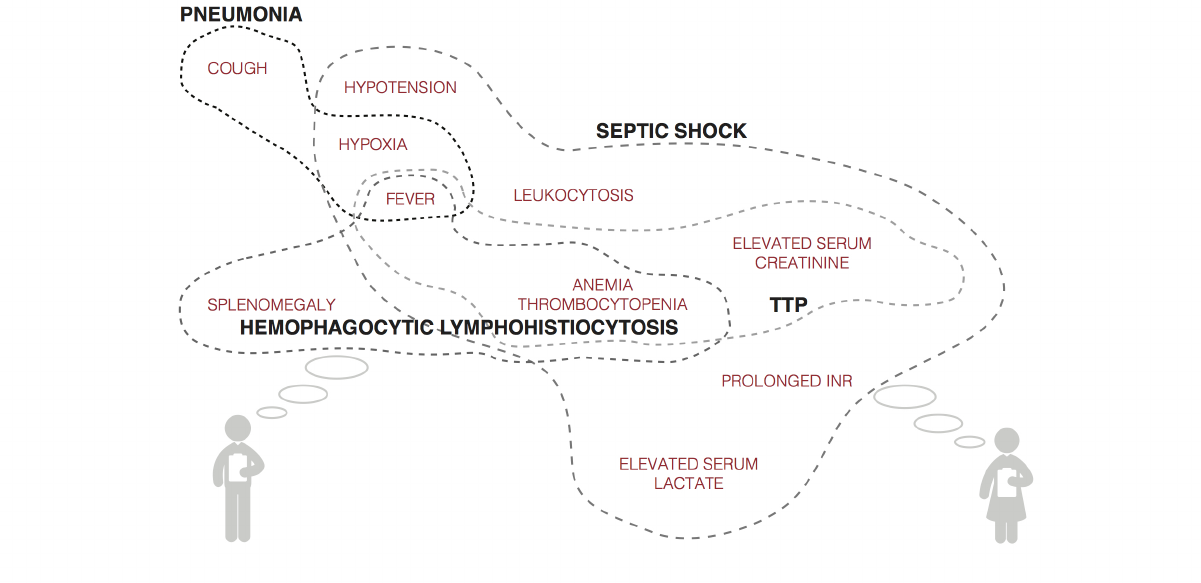
Figure 2. Mock visualization of symptoms, signs, laboratory results, and other data input and systems suggestion for differential